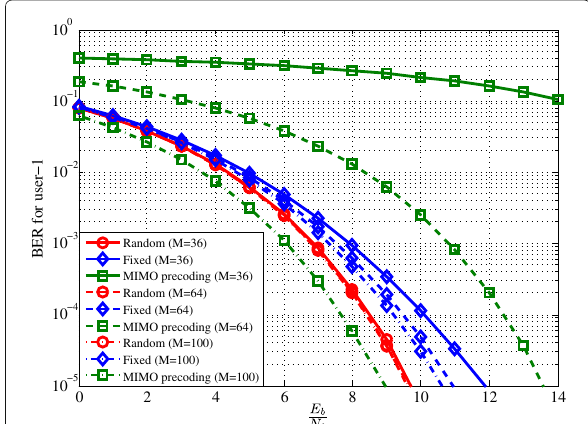
Fig. 10 BER comparison with digital-analog hybrid precoding scheme